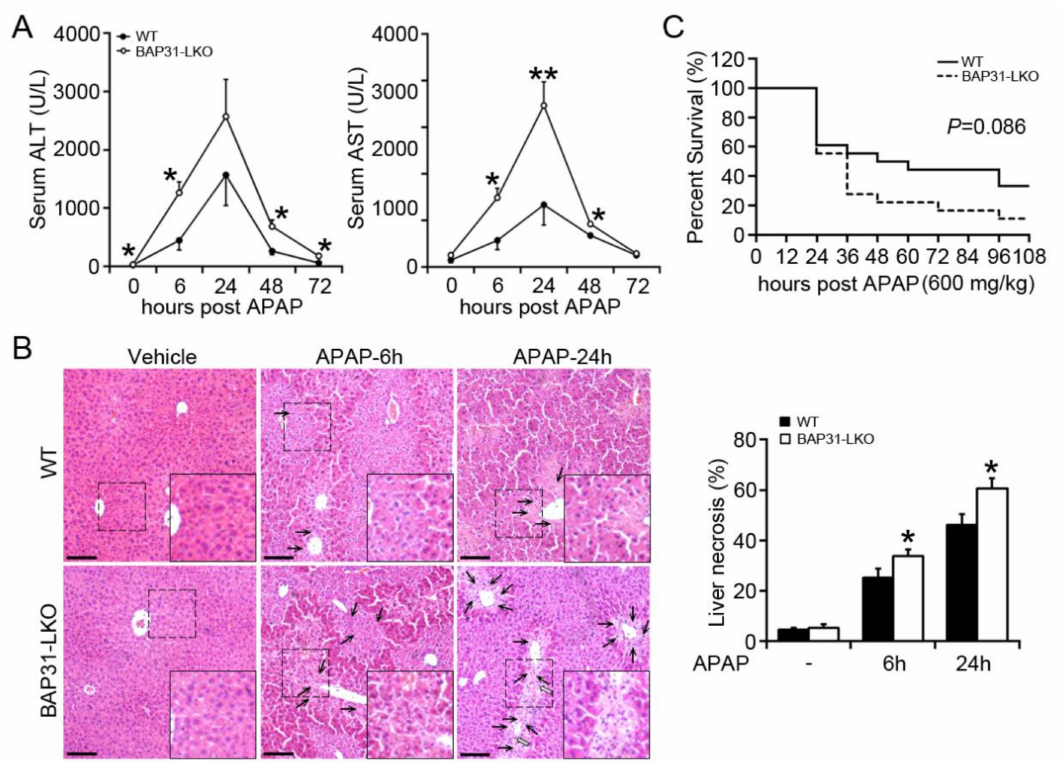
Figure 1. BAP31-deficiency increased APAP-induced liver injury. ( A ) 10-week-old male BAP31-LKO mice and the littermates were i.p. injected with 300 mg/kg APAP after overnight food deprivation. Serum ALT and AST levels were measured at various time points. n = 5–7 per group. ( B ) Representative images of H/E staining of liver tissues (left panel). Area of necrosis (% of area) was determined (right panel). Black arrows indicate necrotic hepatocytes. White arrows indicate neutrophil infiltration. Scar bar = 100 µ m. n = 4 per group. ( C ) The survival rate of WT and BAP31-LKO mice at different time points after injection with a lethal dose of APAP (600 mg/kg). n = 18 per group. Data are expressed as mean ± SE. *, p < 0.05, **, p < 0.01, BAP31-LKO compared to WT